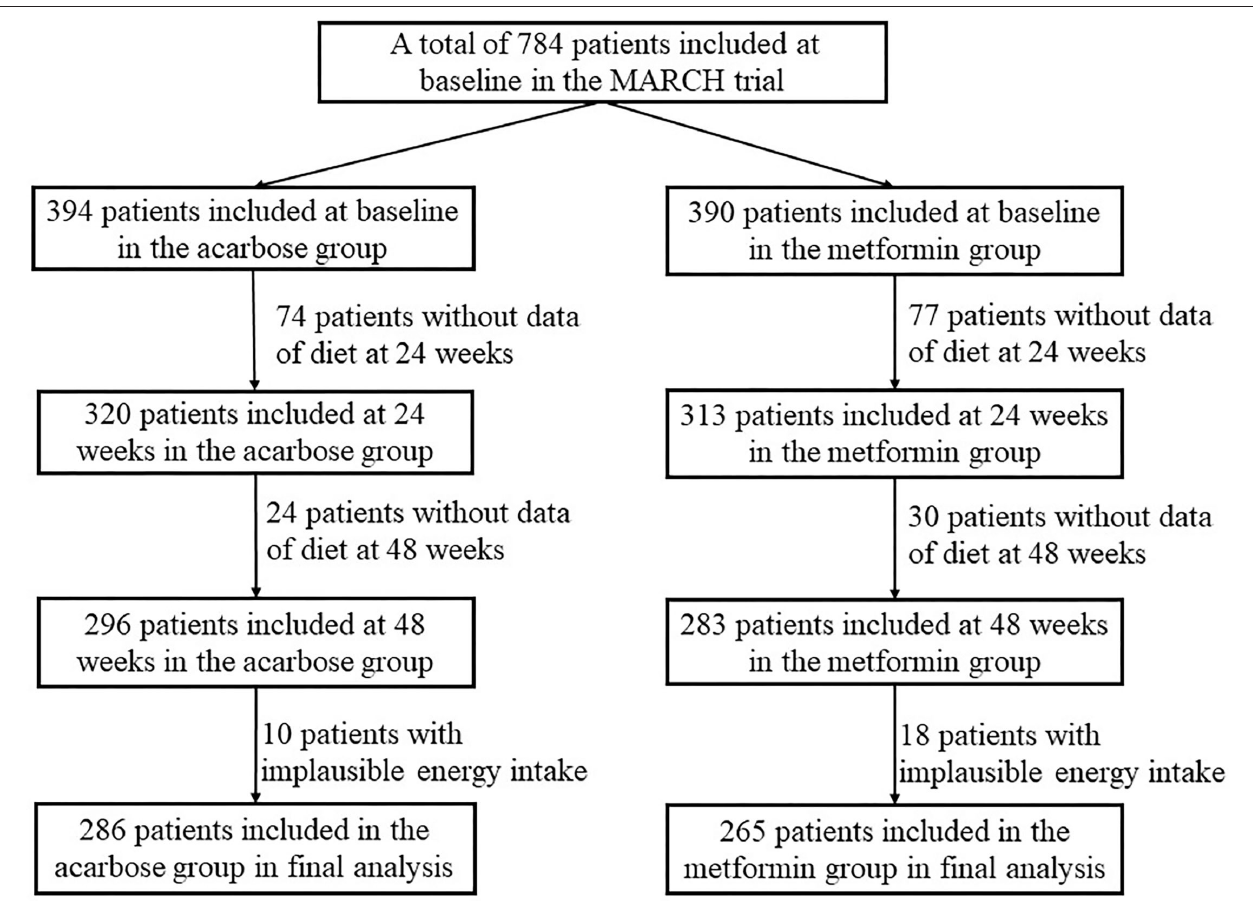
FIGURE 1 | Flowchart for the selection process of the current study population in the metformin and acarbose in Chinese as the initial hypoglycemic treatment (MARCH) trial.